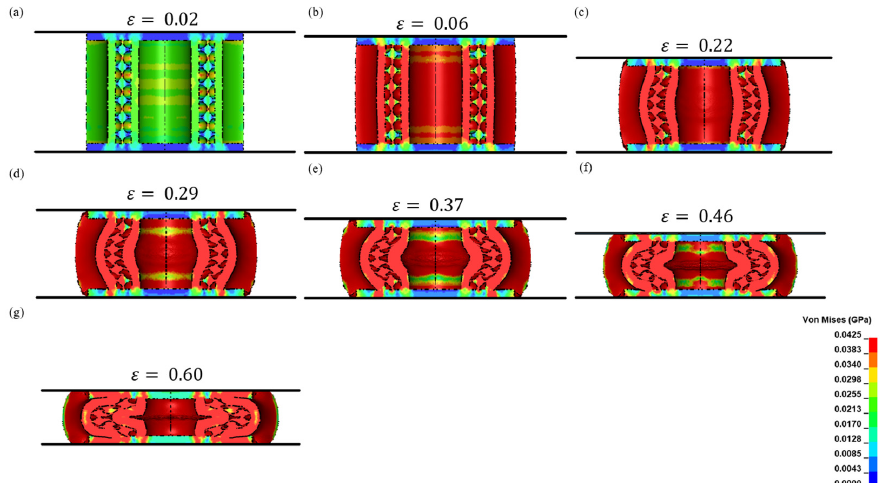
Figure 15. Stress transmission within the structure at different strain levels during compression ( a ) 𝜀 = 0.02 ( b ) 𝜀 = 0.06 ( c ) 𝜀 = 0.22 ( d ) 𝜀 = 0.29 ( e ) 𝜀 = 0.37 ( f ) 𝜀 = 0.46 ( g ) 𝜀 = 0.60 .